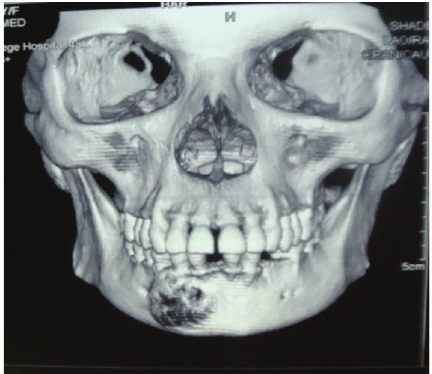
Figure 2: 3D reformatted CT illustrating size and location of the well-defined tumor.